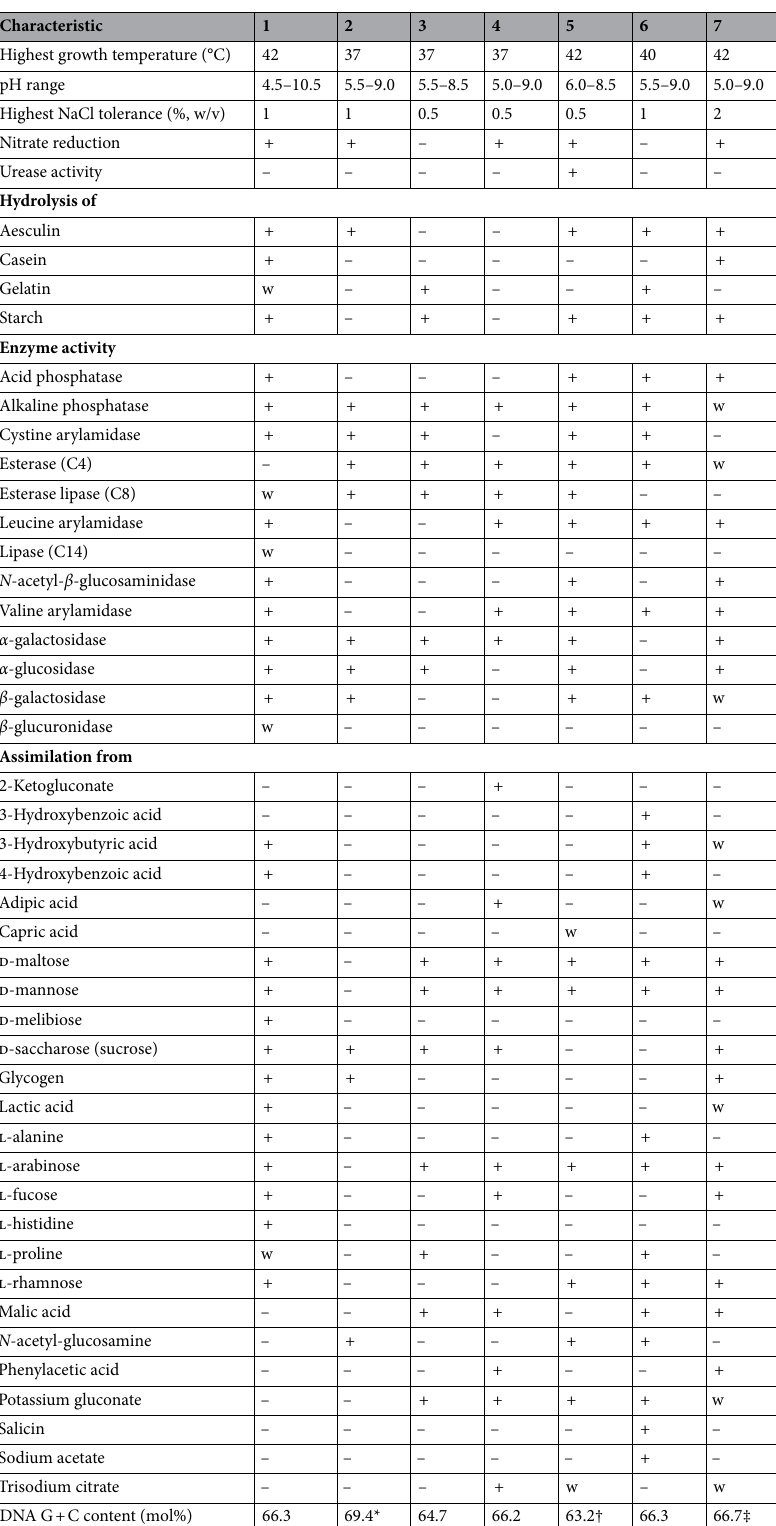
Table 3. Phenotypic characteristics of strain TW-1 T that differentiates with phylogenetically related species of the genus Massilia . Strains: 1, TW-1 T ; 2, M. pinisoli KACC 18748 T ; 3, M. putida KACC 21418 T ; 4, M. phosphatilytica KACC 21417 T ; 5, M. arvi KACC 21416 T ; 6, M. niastensis KACC 12599 T ; 7, M. kyonggiensis KACC 17471 T . All data were obtained from this study except otherwise indicated. + , positive; w, weak; –, negative. Data from *Altankhuu and Kim 12 ; †Singh et al . 9 ; and ‡Kim 21